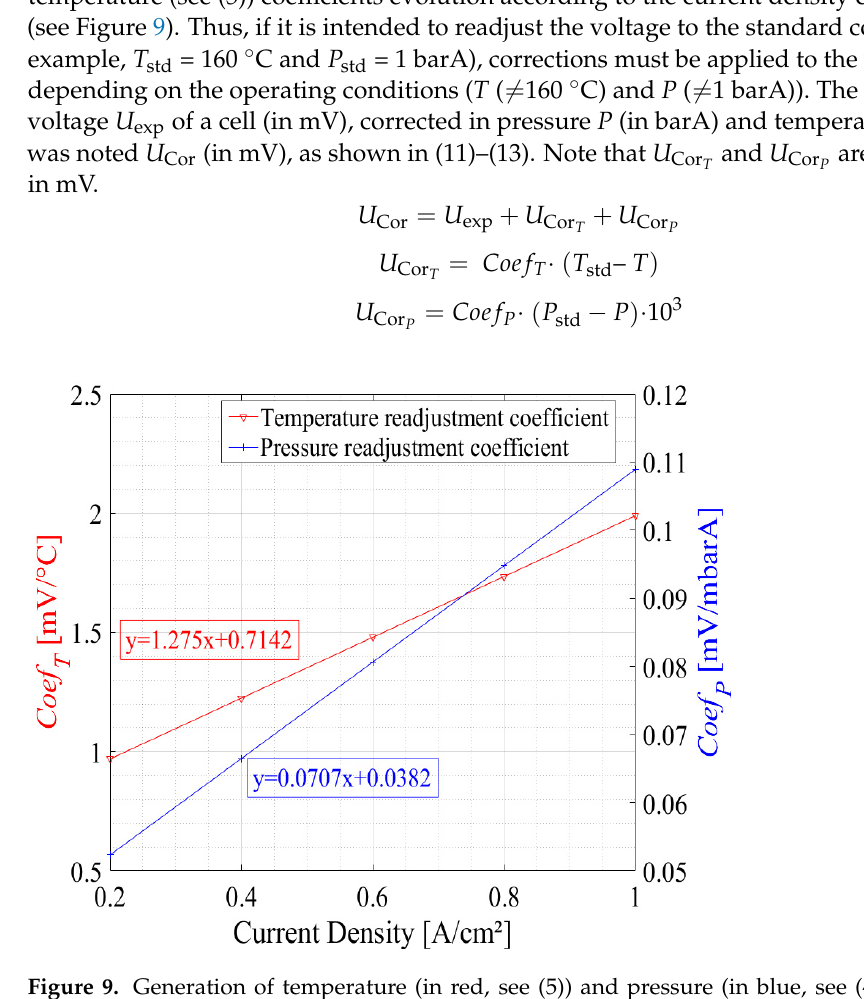
Figure 10. Application of the readjustment methodology for the pressure to the voltage from Figure 1. The corrected voltage 𝑈 (cid:2887)(cid:2925)(cid:2928)(cid:2869) is given at a standard pressure of 1 barA.